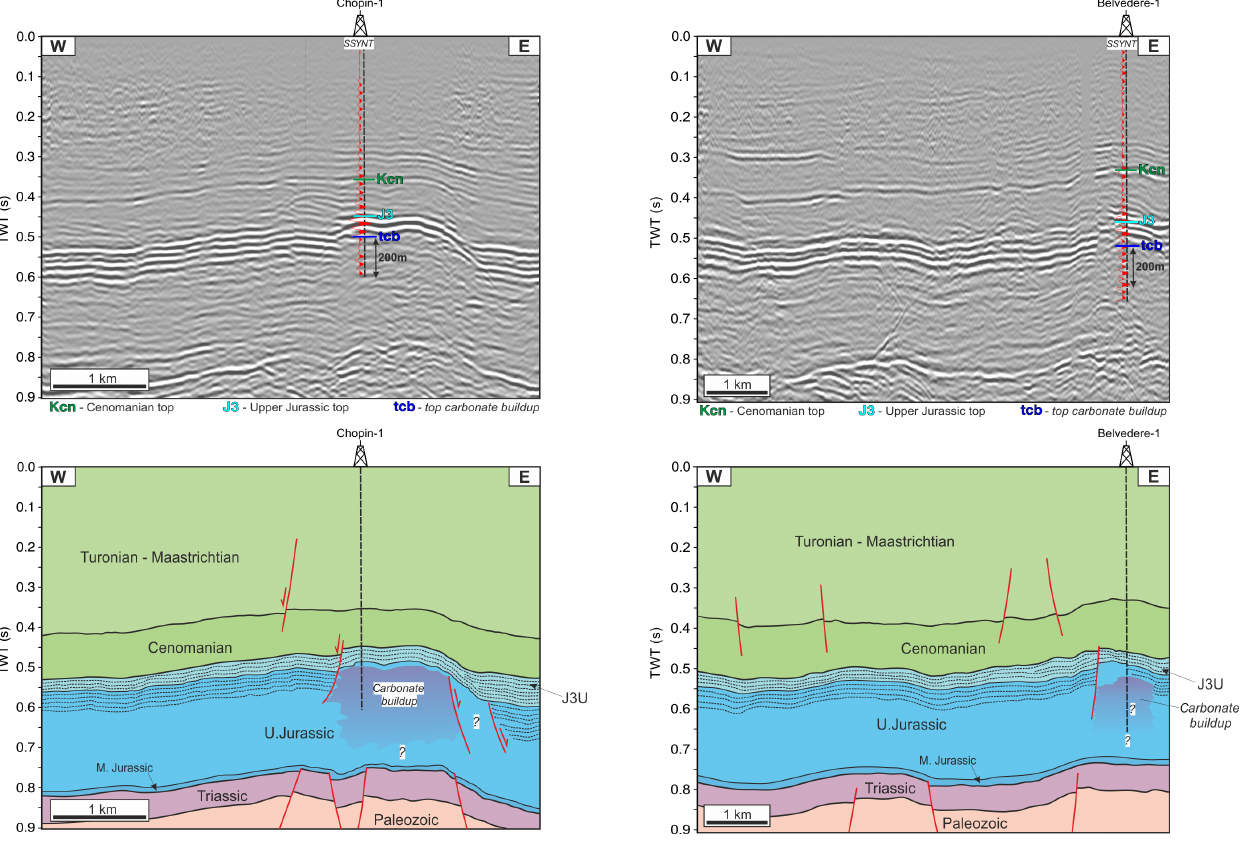
Figure 12. Uninterpreted and interpreted seismic profile across the carbonate buildup complex (see Fig. 5 for location). This carbon- ate buildup was partly drilled by the Belvedere-1 well. Well tops, the interpreted top of the carbonate buildup (tcb) and the synthetic seismogram (SSYNT) are shown (see Fig. 7 for